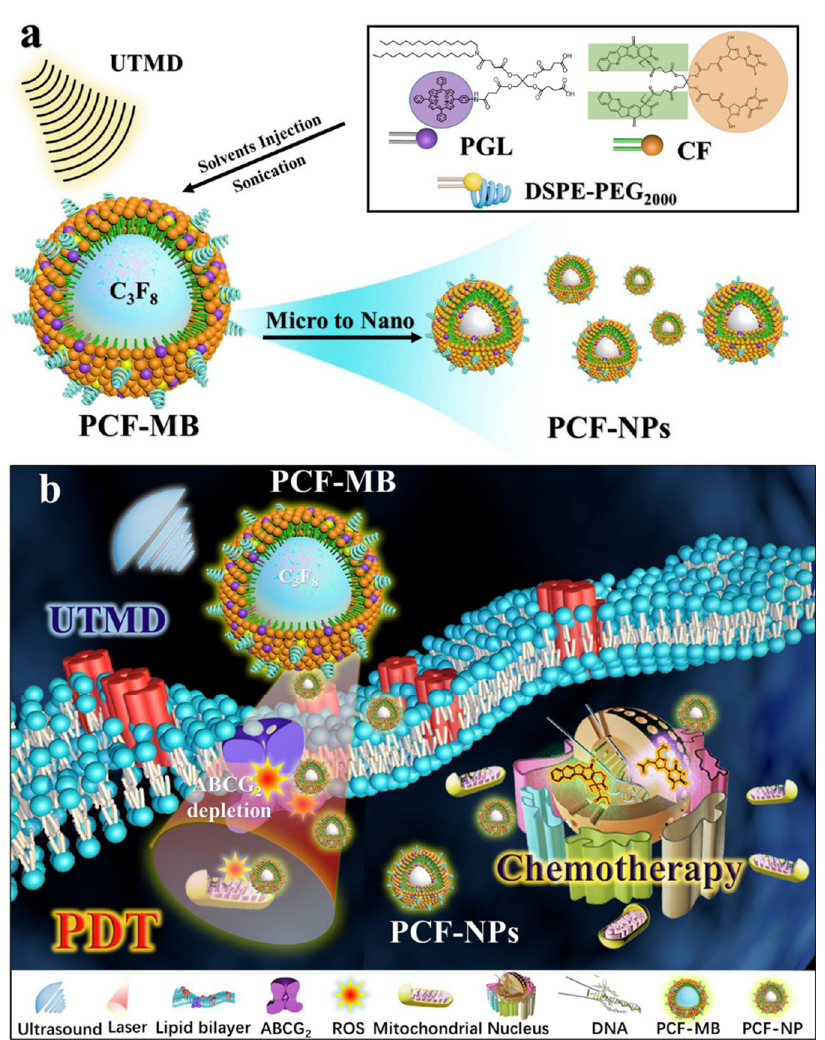
Figure 10. ( a ) Schematic illustration of self-assembly of PCF-MB with porphyrin grafted lipid of PGL and camptothecin-floxuridine conjugate of CF, which can be converted into PCF-NP by ultrasound